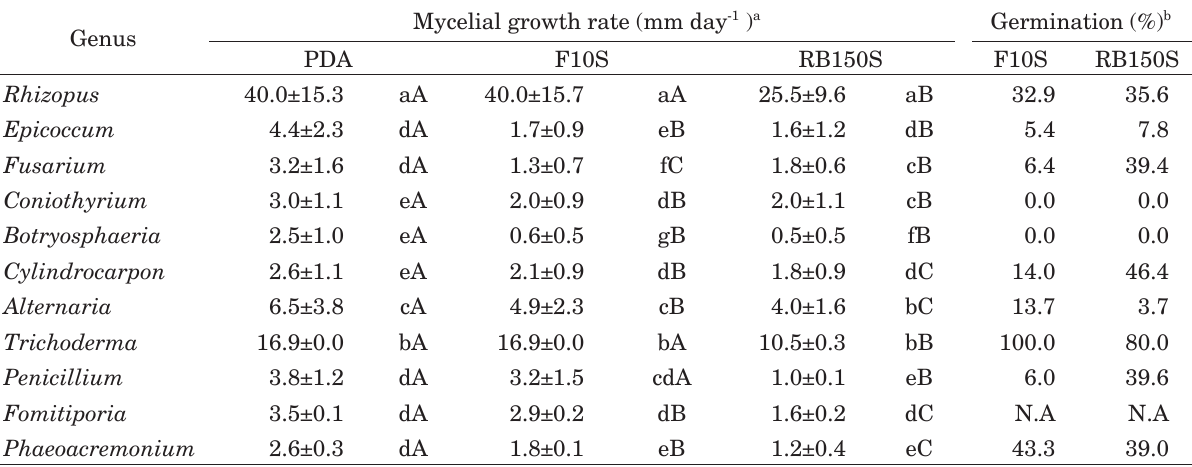
Table 2. Daily mycelial growth rate (mm diameter) of accompanying fungi on three culture media (PDA, F10S and RB150S) and spore germination on FS10 and RB150S media.